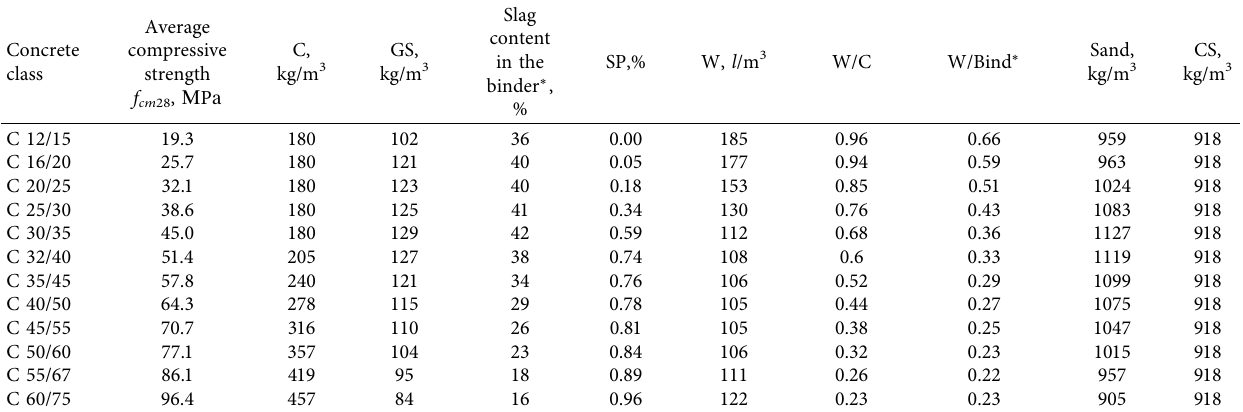
Table 8: Optimization results according to Task